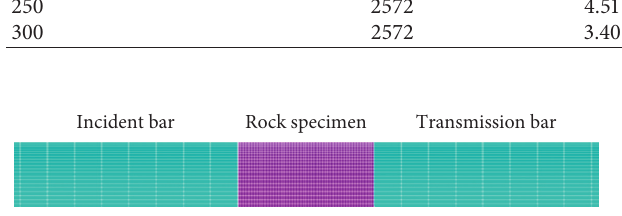
Figure 8: Establishment of the numerical simulation SHPB